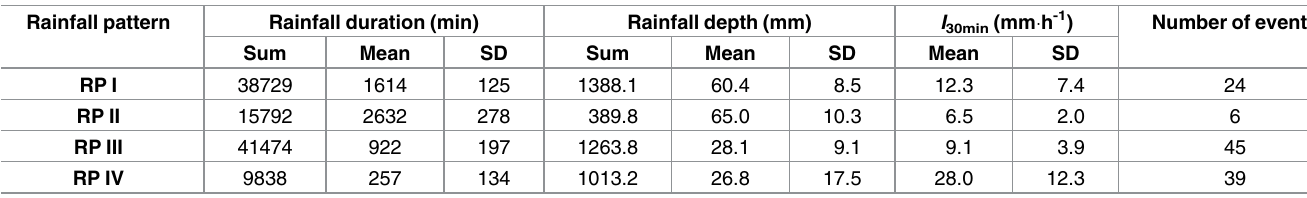
Table 1. Eigenvalue statistical featuresof the four rainfall